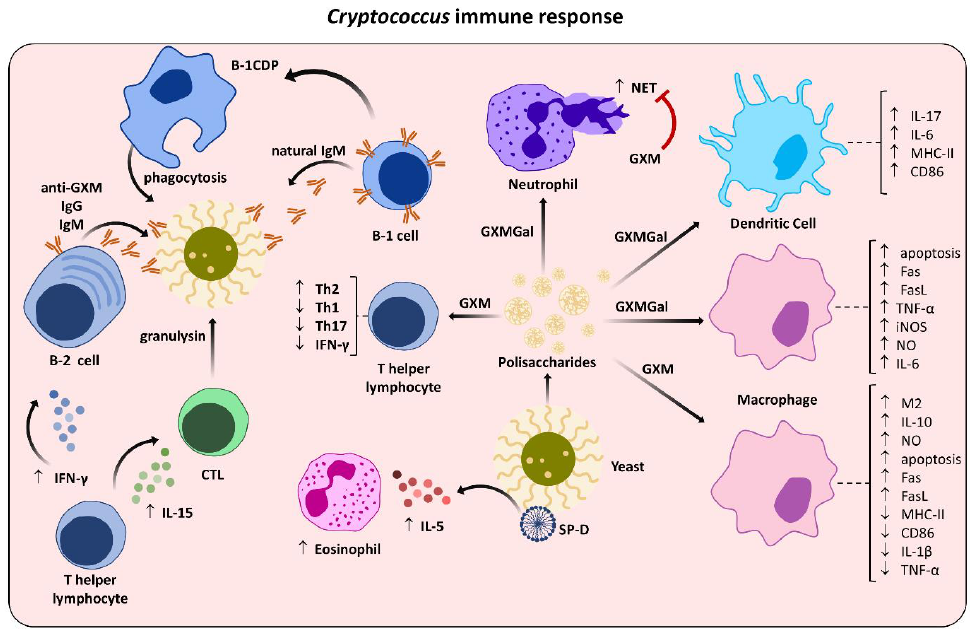
Figure 3. Immune response against Cryptococcus spp. and its capsular polysaccharides immunomodulatory effects.